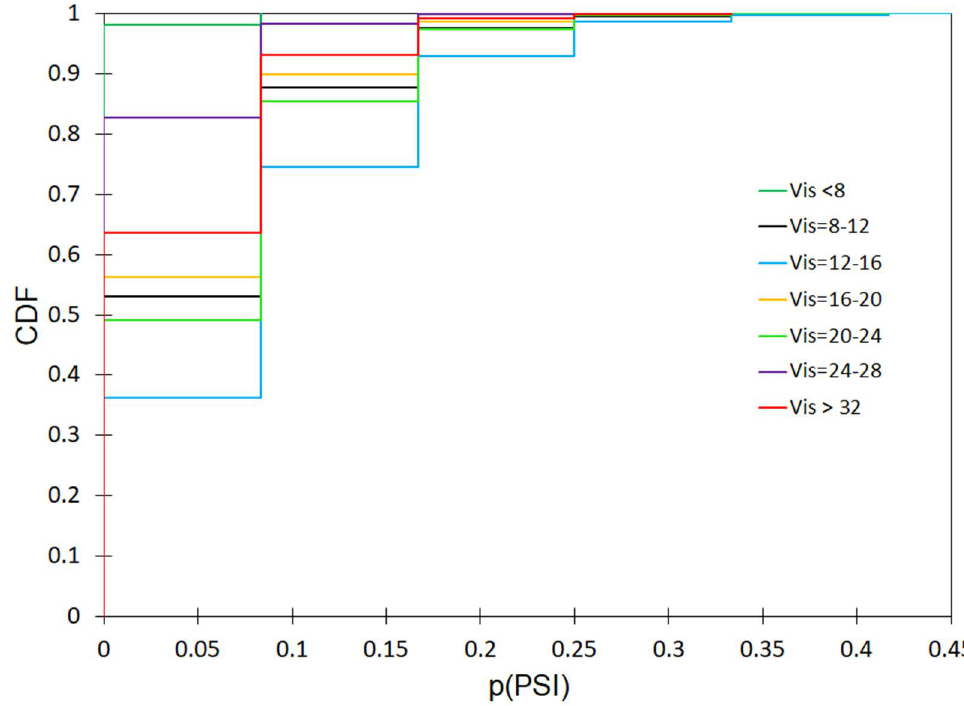
Figure A37. Effect of visibility on the incidence of mean spring mortality for rainy days.